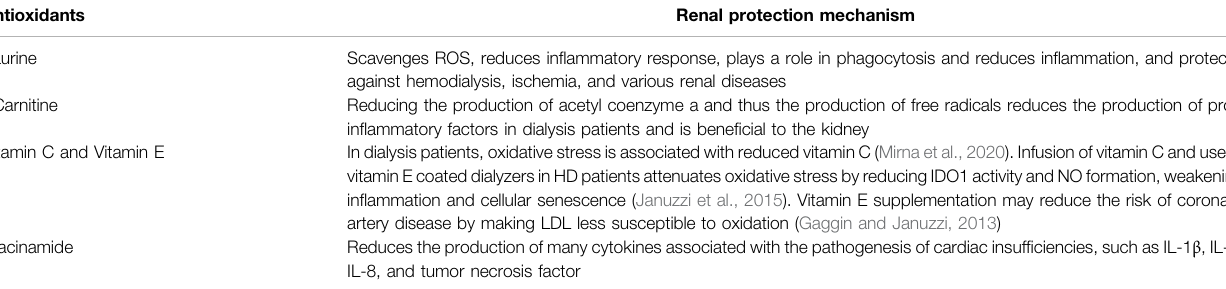
TABLE 3 | Protective effects of common antioxidant substances on cardiac function in dialysis patients. Antioxidants Renal protection mechanism